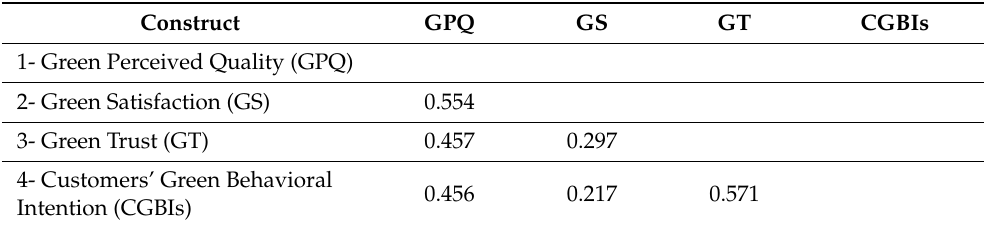
Table 4. Discriminant Validity via HTMT. Construct GPQ